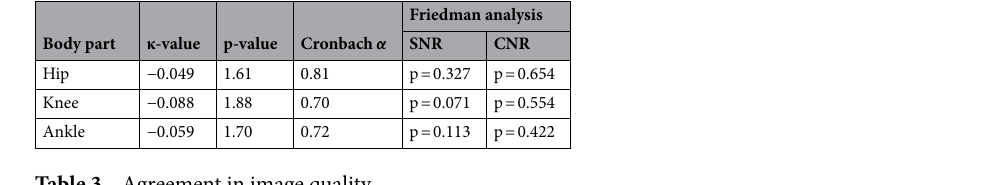
Table 3. Agreement in image quality.